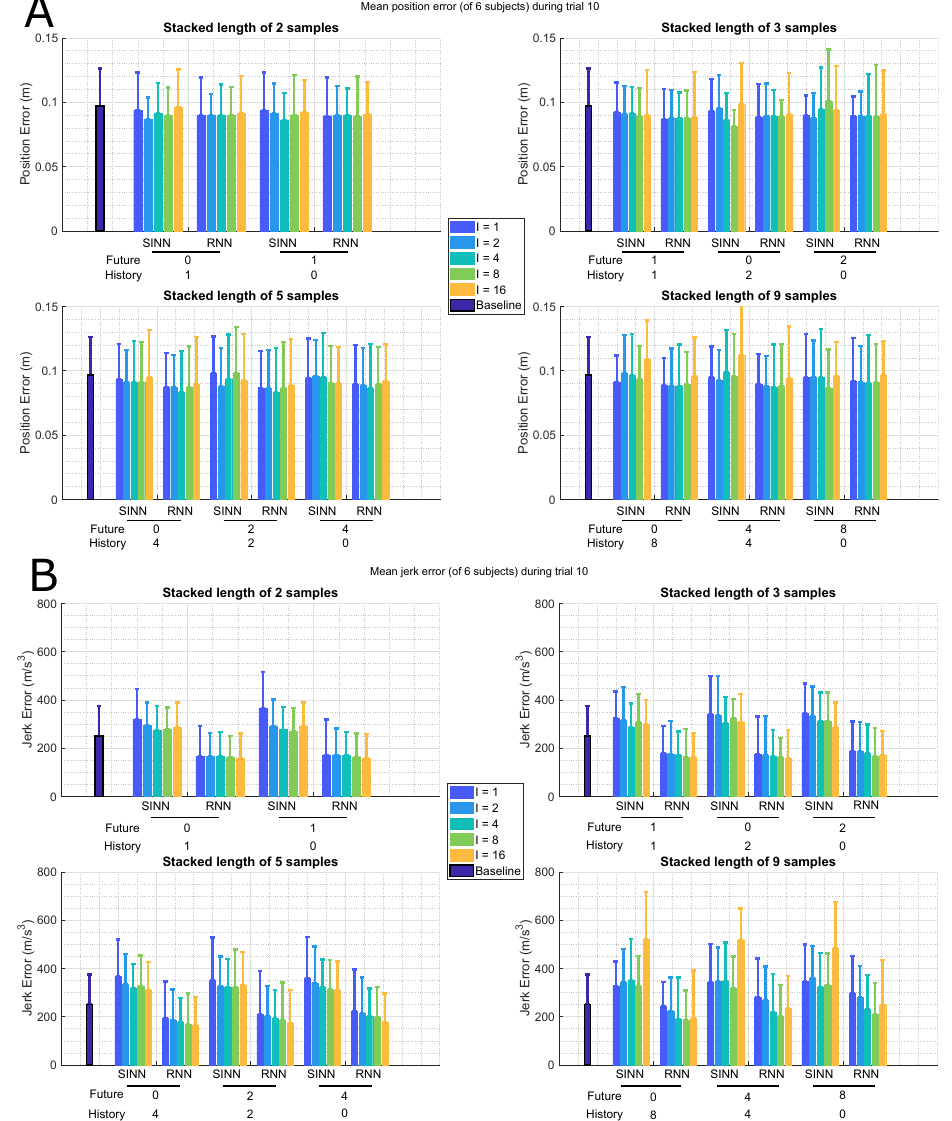
Figure 6. Bar plots of the full-body mean (of 6 subjects) joint position ( A ) and jerk ( B ) error for the shallow (SINN, left bars for each configuration ) and deep (RNN, right bars for each configuration) learning approaches during a sports trial (10 in Table 1), standard deviation over the various subjects is displayed by whiskers. The different time windows are presented on the x -axis, where the number of past ( P ) and future ( F ) poses are shown. The interval ( I ) between input poses are marked by the different colours, where the number of samples between input poses is shown. For comparison, the baseline (L A ) for using only the current pose as input mean joint position ( A ) and jerk ( B ) errors are shown as the dark blue bars on the